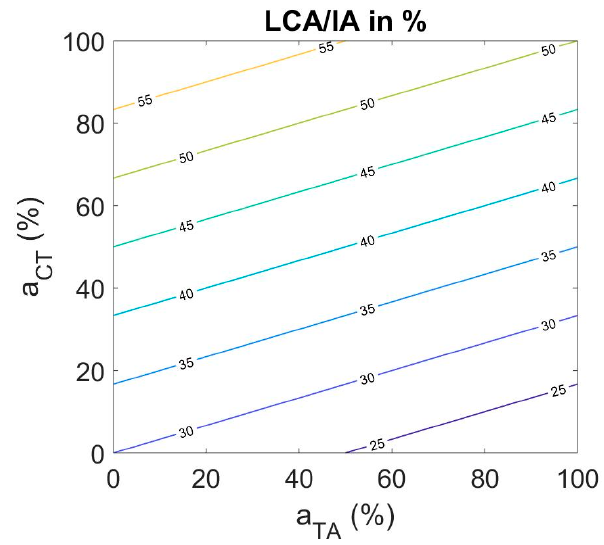
Figure 4. Muscle activation plot with LCA/IA activation as contour parameter.